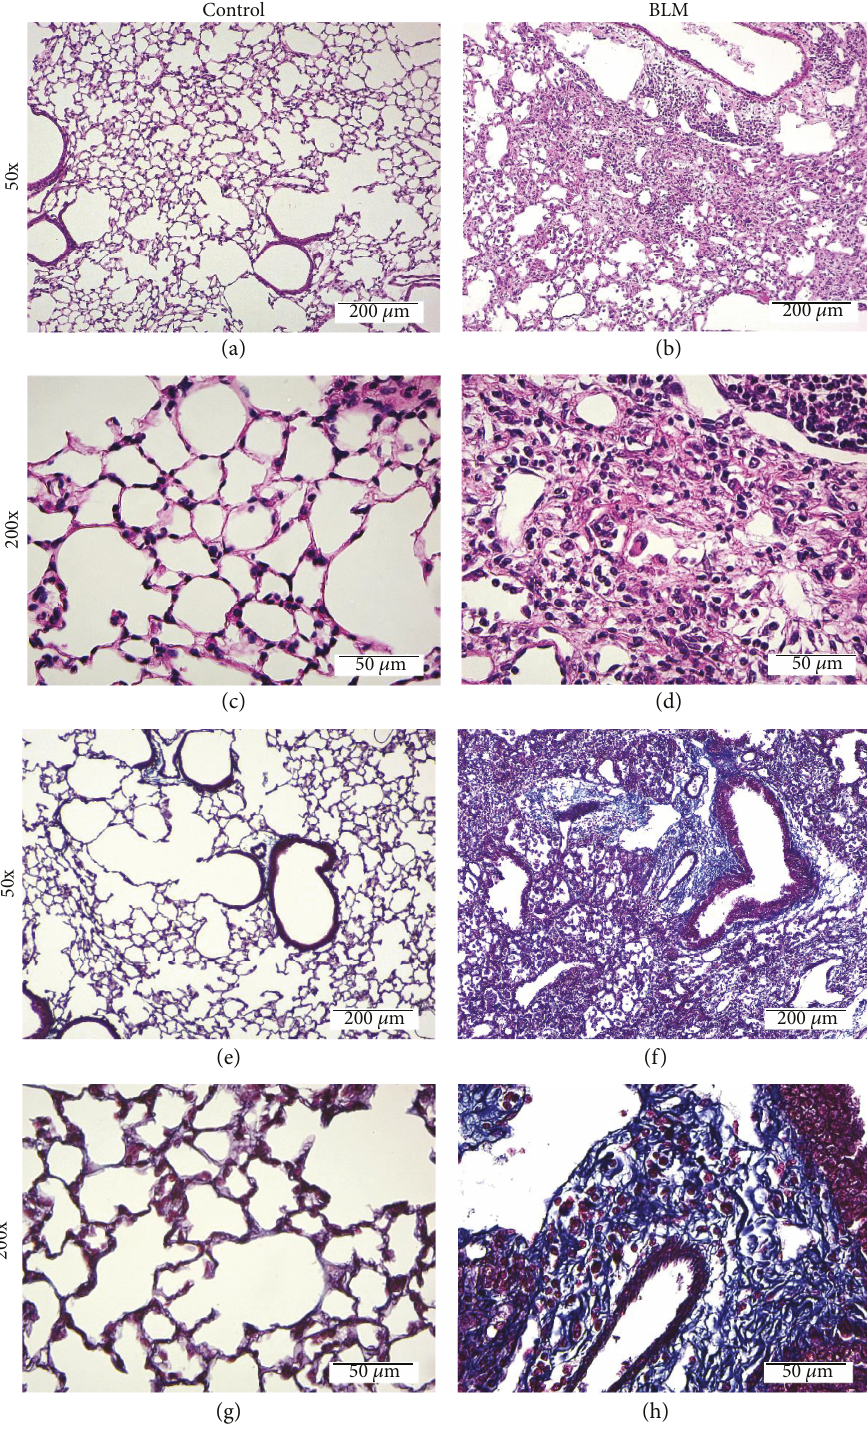
Figure 1: BLM-induced lung fi brosis in mice. C57BL/6 mice were intratracheally administered bleomycin (2 mg/kg) for 14 days. (a – d) Lung H&E staining. (e – h) Masson ’ s trichrome staining of lung tissue from (a, c) control mice and (b, d) BLM-induced lung fi brosis mice. The photos in (a, b, e, and f) represent 50x magni fi cation. The photos in (c, d, g, and h) represent 200x magni fi cation. The collagen in lung fi brosis tissue was stained blue by Masson ’ s trichrome staining. Bar = 200 μ m at 50x magni fi cation and 50 μ m at 200x magni fi cation as